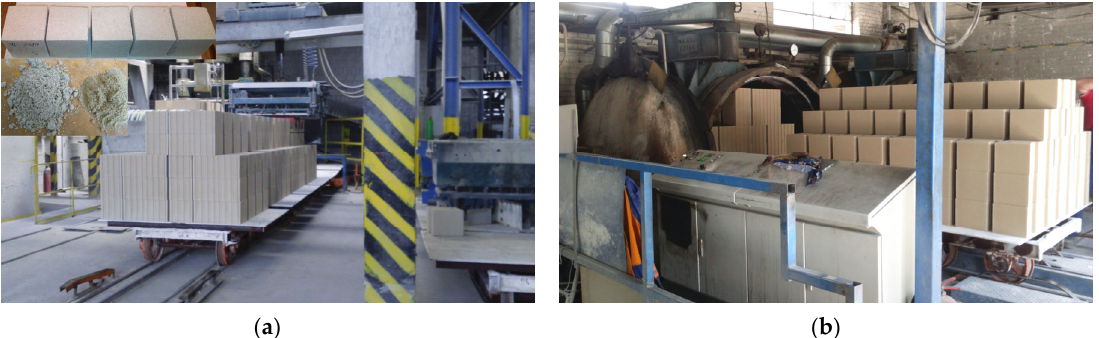
Figure 29. Example silicate brick production line (Ludynia, Poland); ( a ) pressing process under pressure of fresh silicate mass; ( b ) autoclaving process of pressed and formed silicate brick under